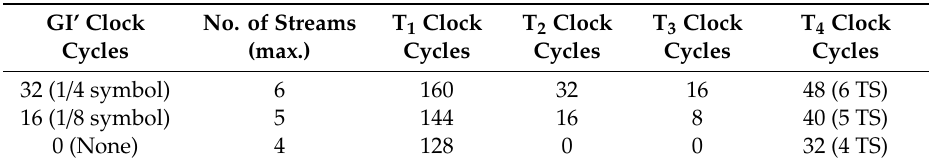
Table 1. Parameters for various operating modes.